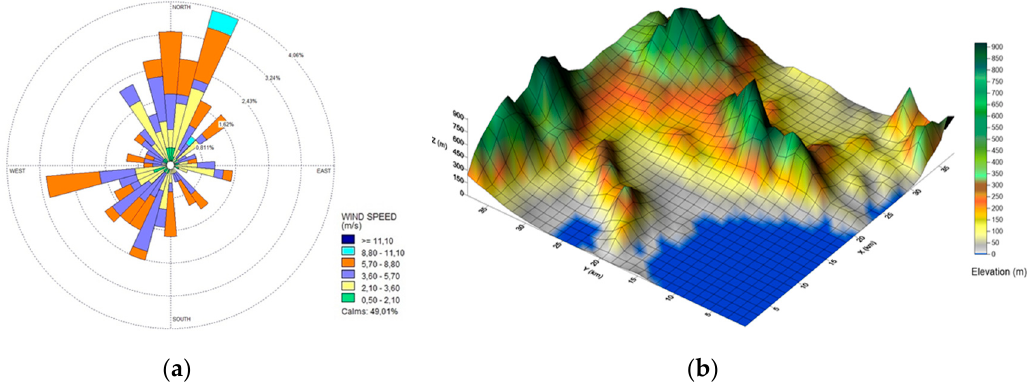
Figure 3. ( a ) Wind conditions (10–16 February 2018) and ( b ) local topography elevation for the GAA [64] (North is in the +Y direction).